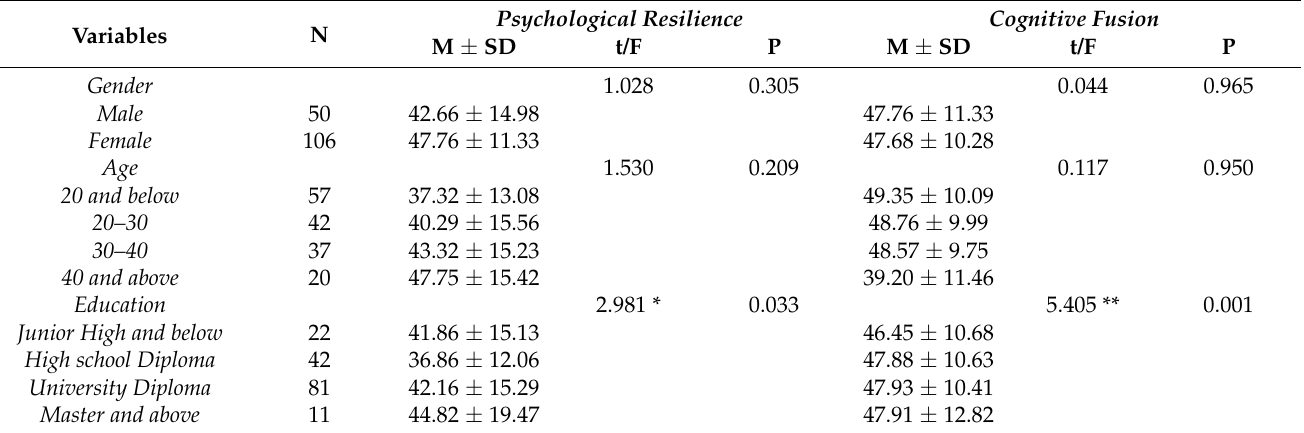
Table 2. Comparison of the scores for psychological resilience and cognitive fusion among patients with depression with different demographic characteristics (scores, x ±